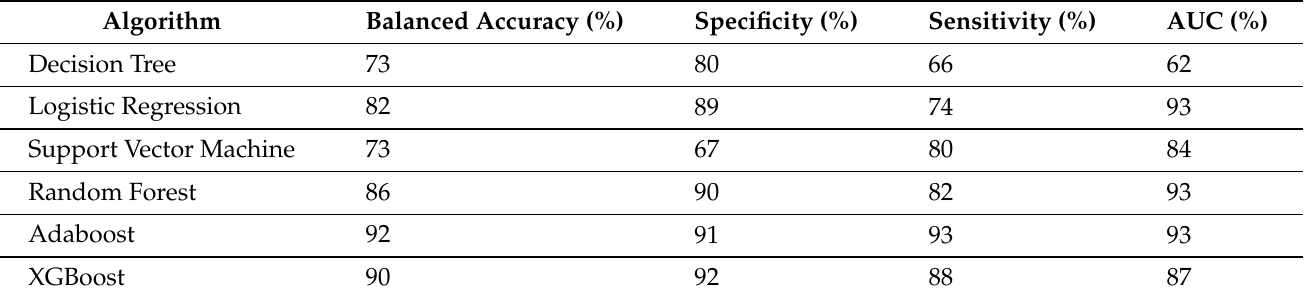
Table 2. Performance measures of the